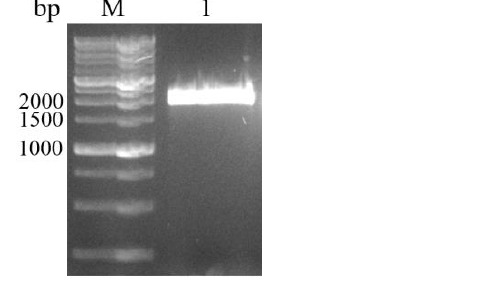
Figure 3. PCR result of the BvAmylase gene. M: DNA marker. 1: BvAmylase gene.